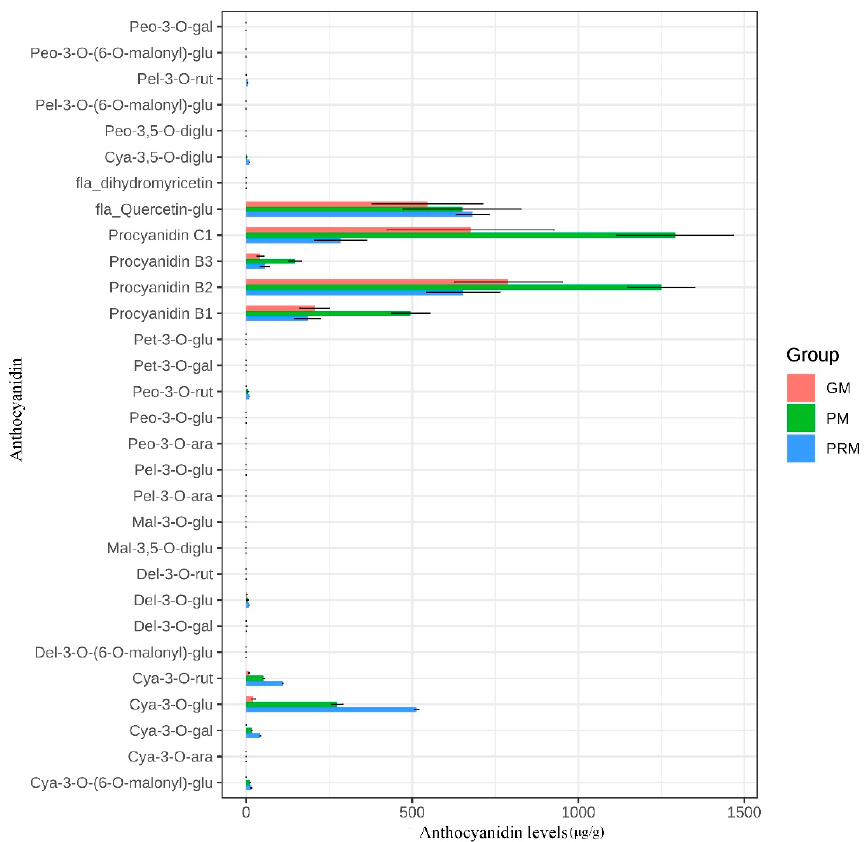
Figure 2. The content of metabolites detected in this study among different samples. The x -axis represents the anthocyanin levels ( µ g/g). The y -axis represents the anthocyanin composition obtained by high-performance liquid chromatography (HPLC). Error bars show standard error (SE) of the mean. GL, green leaves; PL, purple leaves; PRL, purple-red